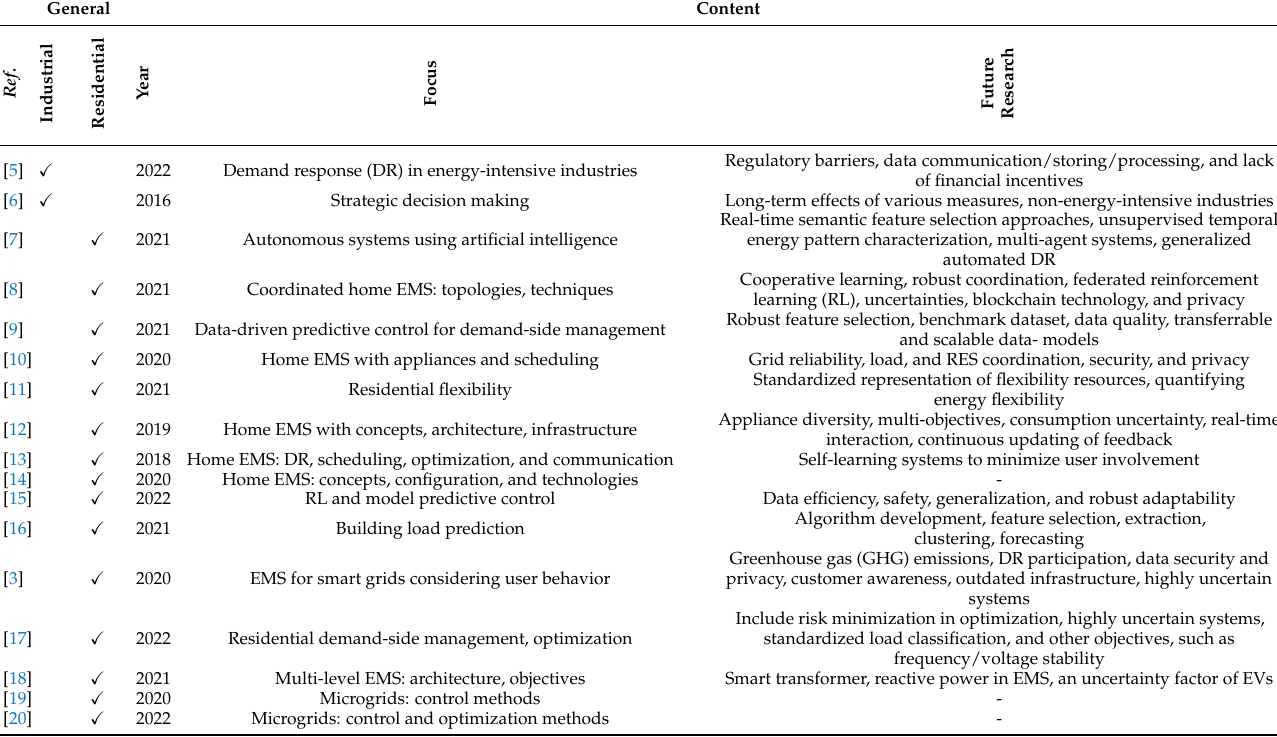
Algorithm development, feature selection, extraction, clustering,